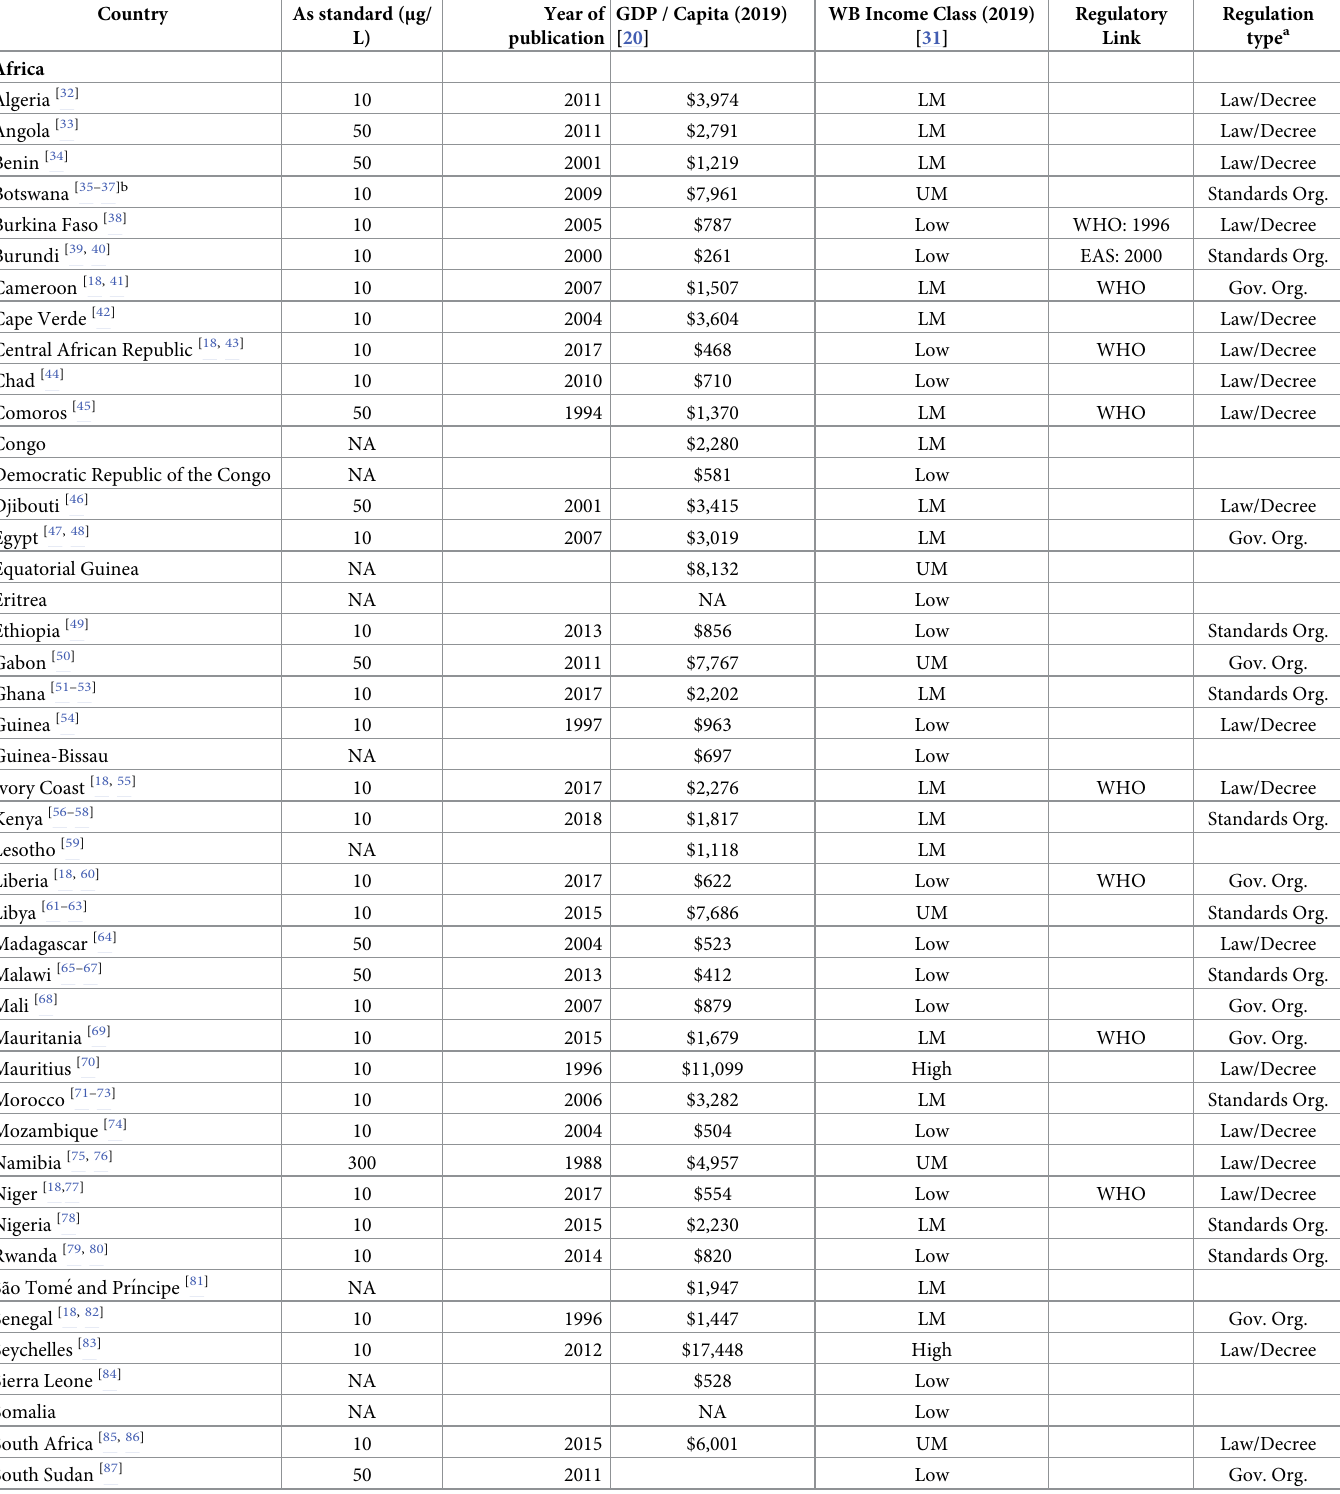
Table 1. International drinking water standards for arsenic and the 2019 gross domestic product (GDP) per capita in United States dollars for 195 countries.